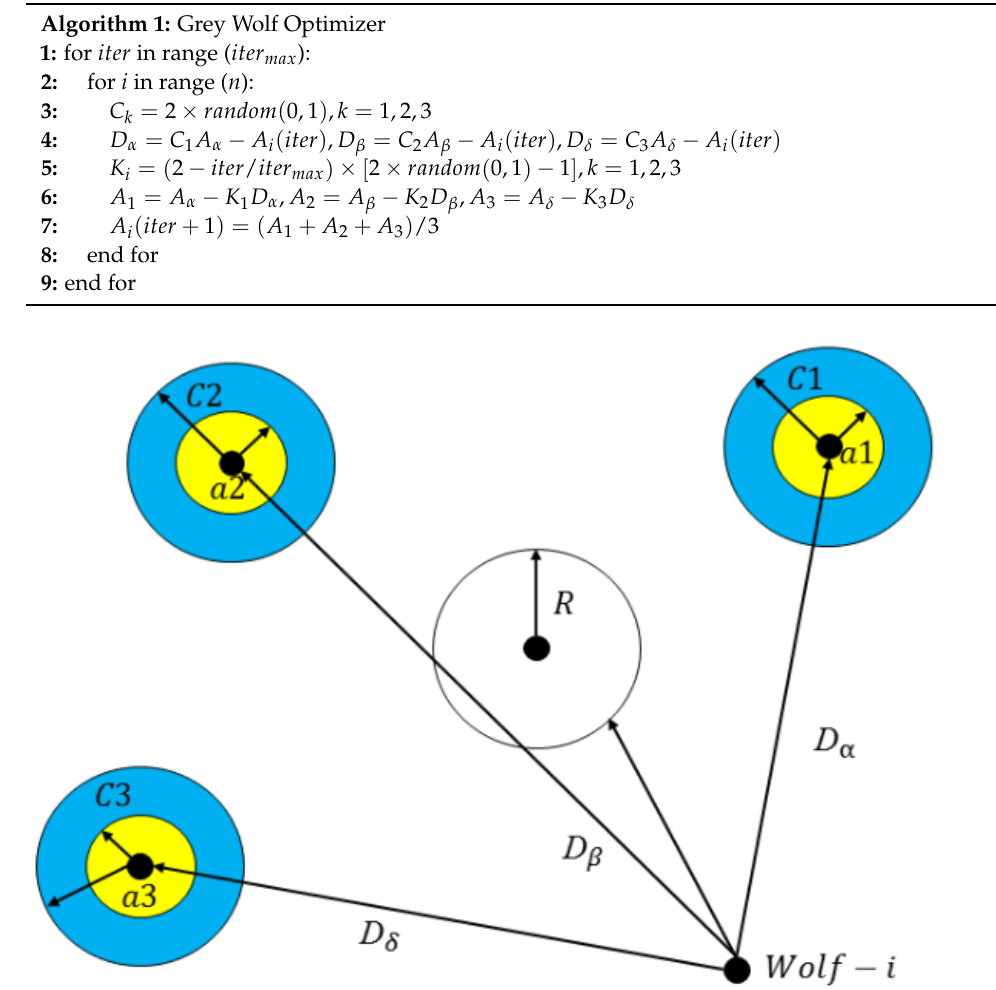
Figure 5. Updating process of